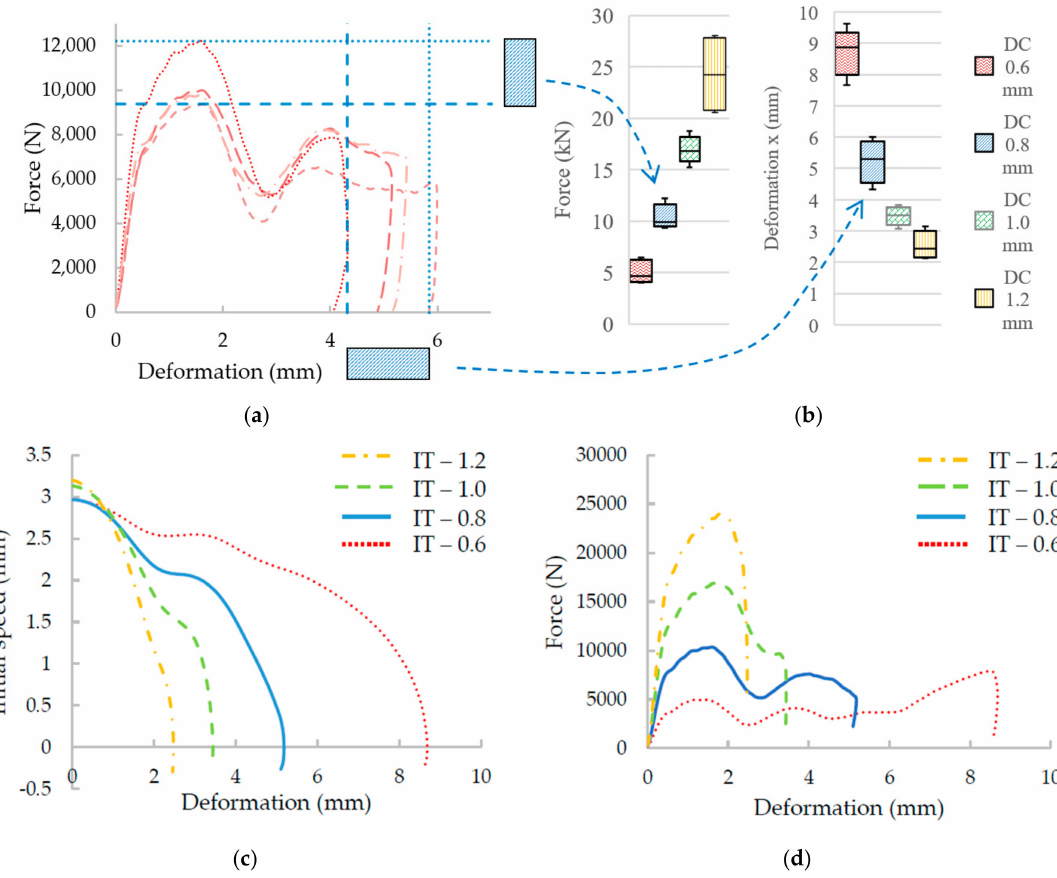
Figure 11. The results from low-velocity impact testing: ( a ) Single IT-series with diameter d = 0.8 mm; ( b ) variance of force and deformation of all IT-series; ( c ) average initial speed, deformation curves; and ( d ) average force-deformation